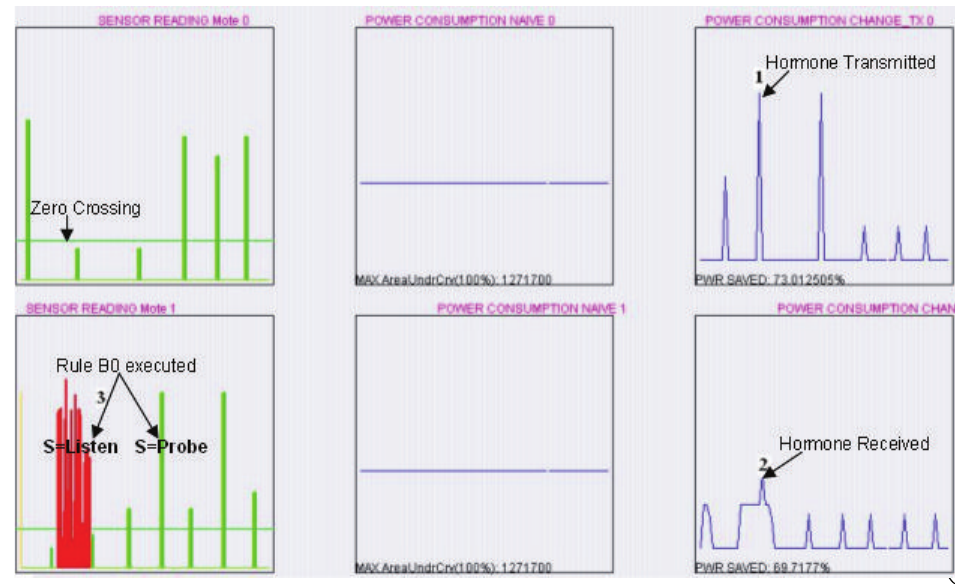
Figure 12: Execution of rule (B0).